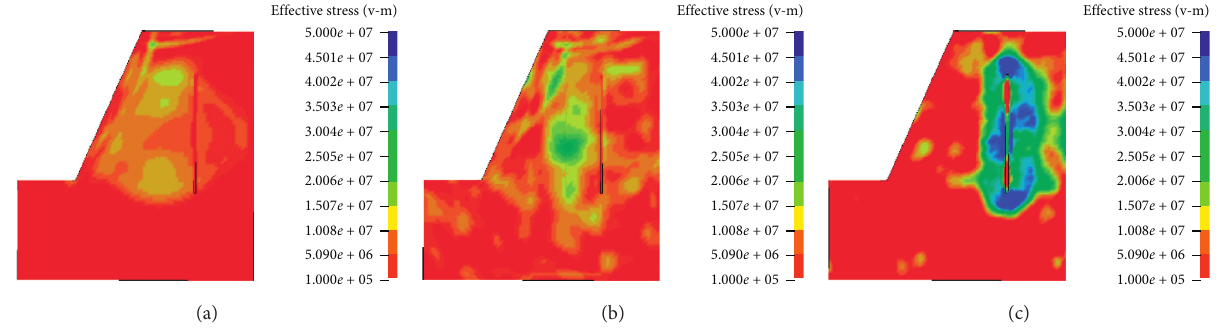
Figure 11: 15m × 5.5 m effective stress of the section between the front holes at different times. (a) t � 1.99ms(b) t � 43.49ms (c) t � 144.00ms.